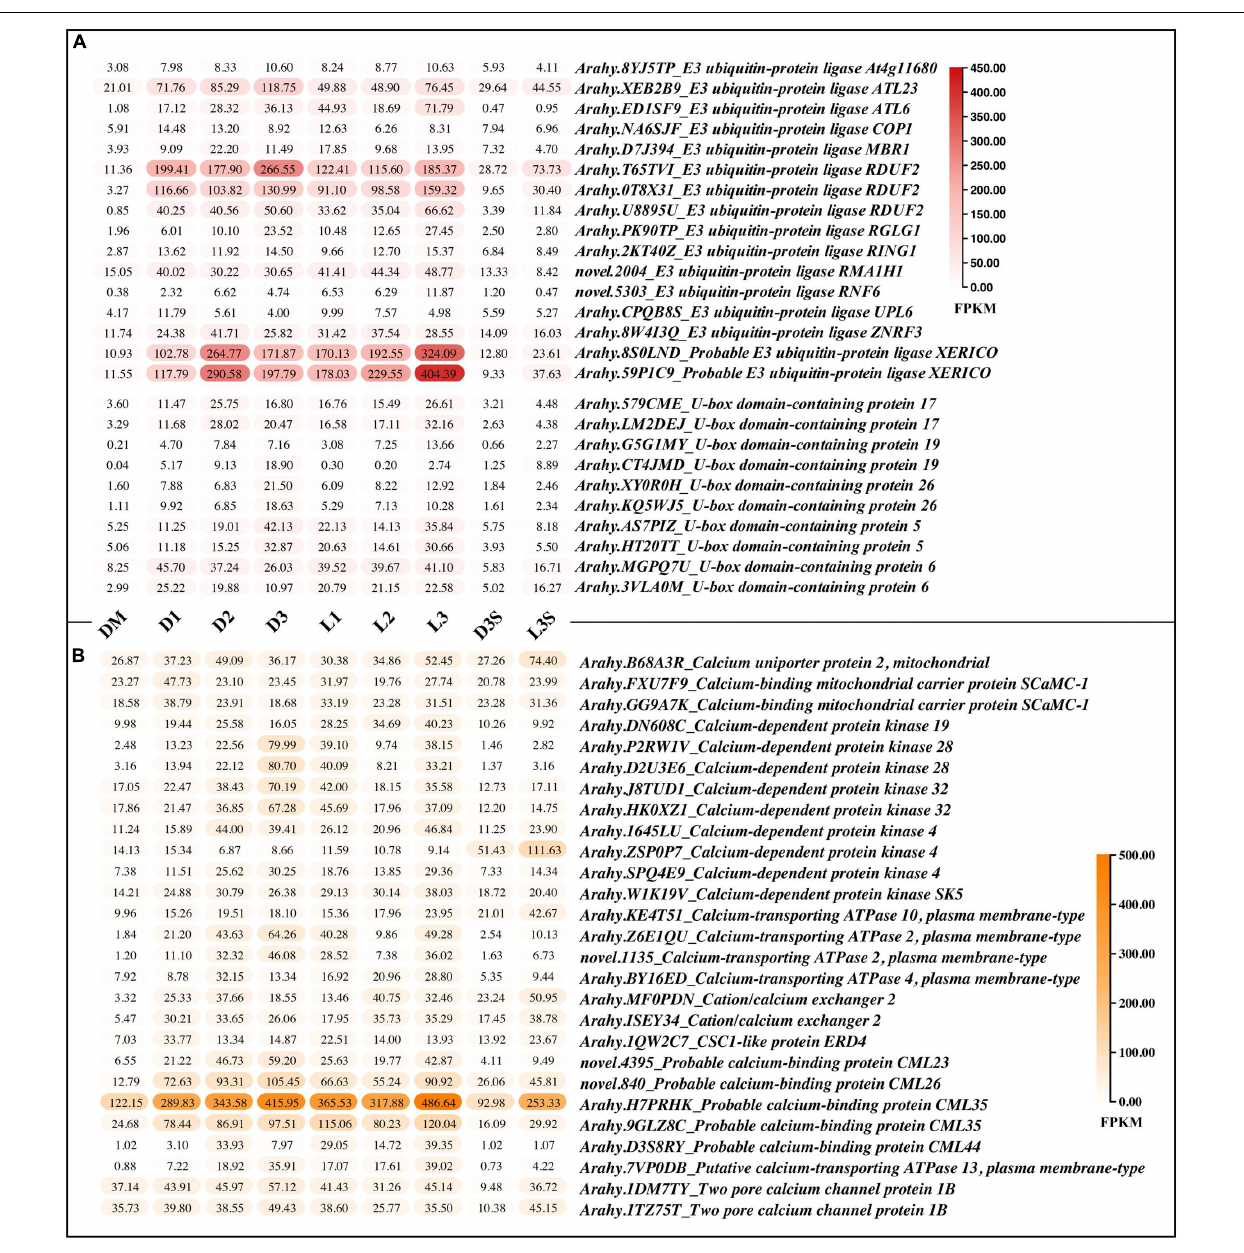
Frontiers in Plant Science |